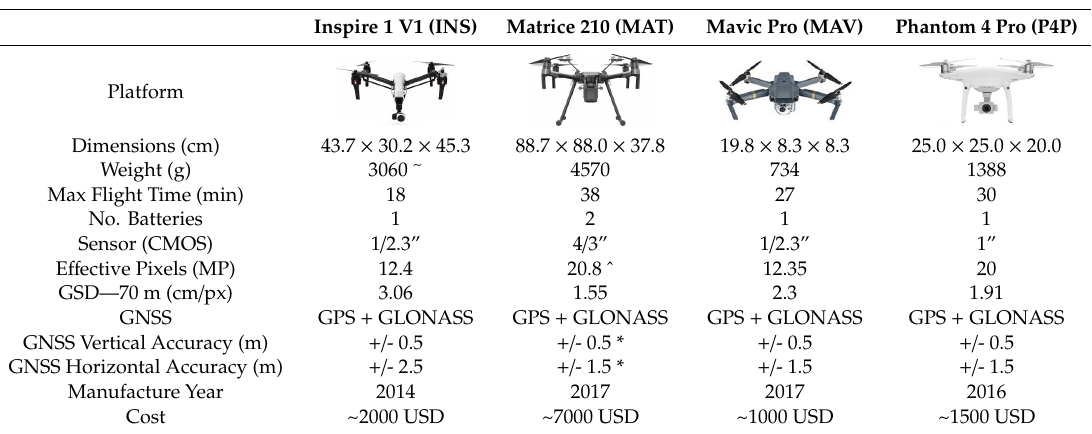
Table 3. Specifications of UAS. All produced by Dà-Ji ā ng Innovations (DJI). No. batteries: number of batteries required to operate. GSD: Ground Sampling Distance (from 70 m altitude); GNSS: Global Navigation Satellite System; GPS: Global Positioning Systems (United States); GLONASS: Global’naya Navigatsionnaya Sputnikovaya Sistema (Russia).